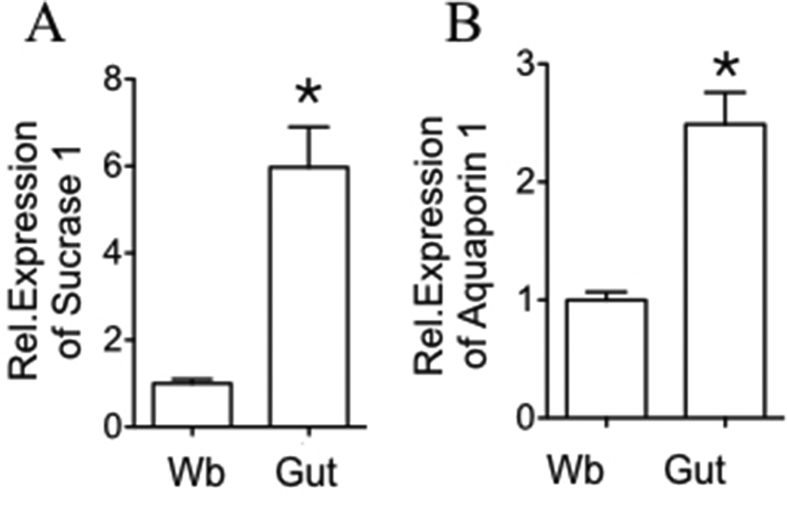
Transcription profiles of SUC1 (A) and AQP1 (B) in the whole body and dissected gut of adult whiteflies. Gene expression was normalized to RPL13. Mean ± s. e. from 3 replicates are shown. * indicate significantly different by Student's t-test.